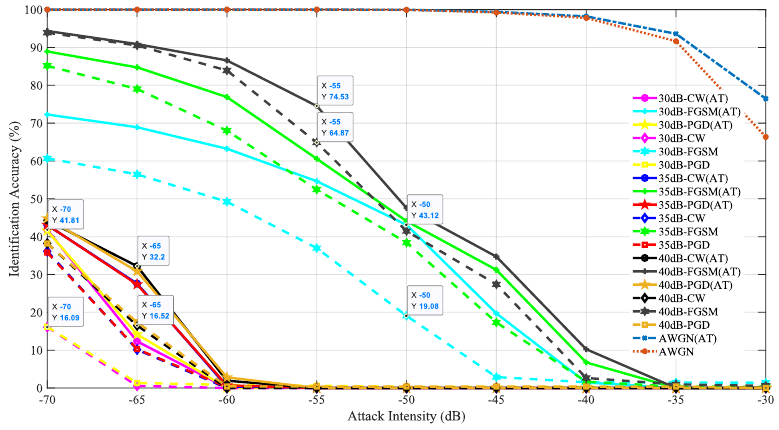
Figure 11. Recognition effect of the system with and without AT for different attack strengths, different attack types and different noise levels for Dataset